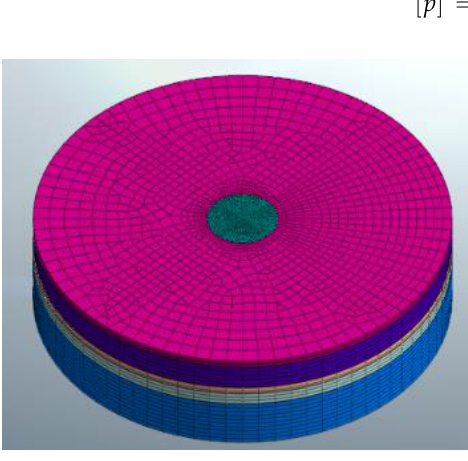
Figure 6. Stiffness matrix analysis model.